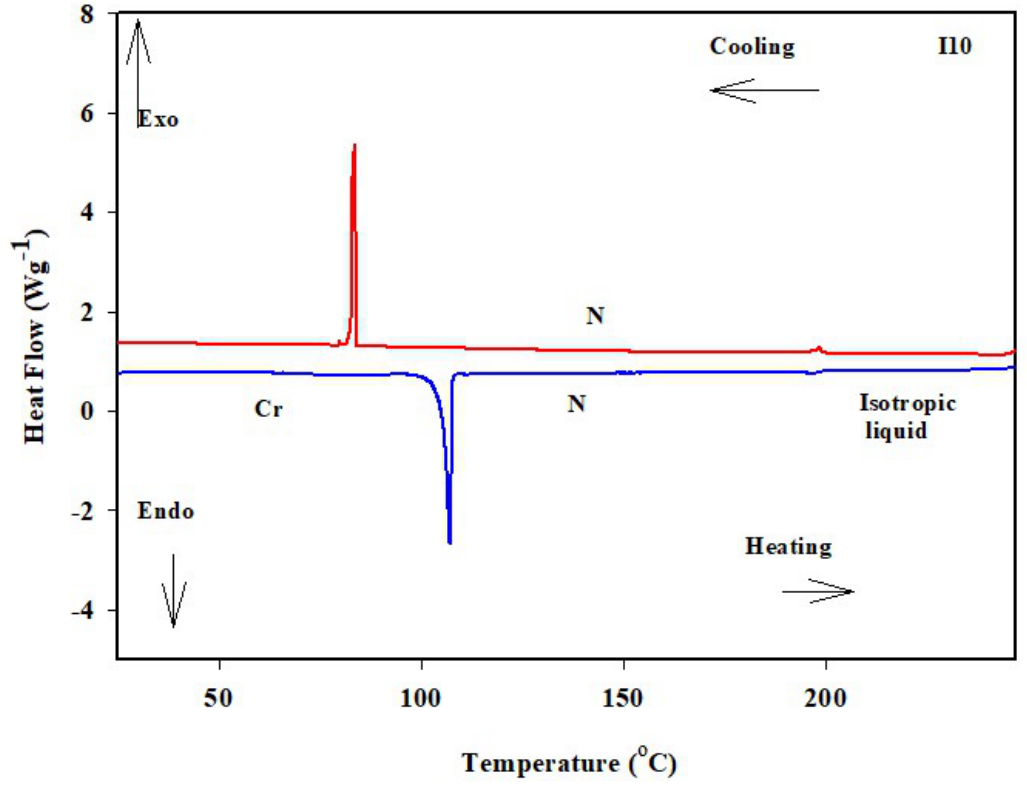
Figure 1. The DSC curve of sample I10 on heating/cooling rounds at a heating rate of 10 ◦ C min − 1 .